Question: Identify the chart type used in this figure.
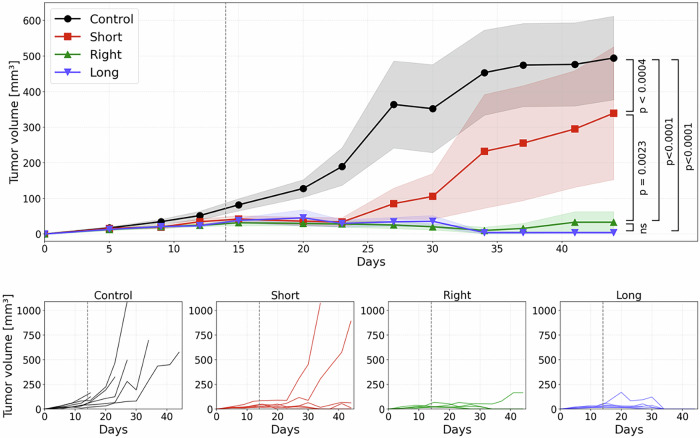
Answer: bar